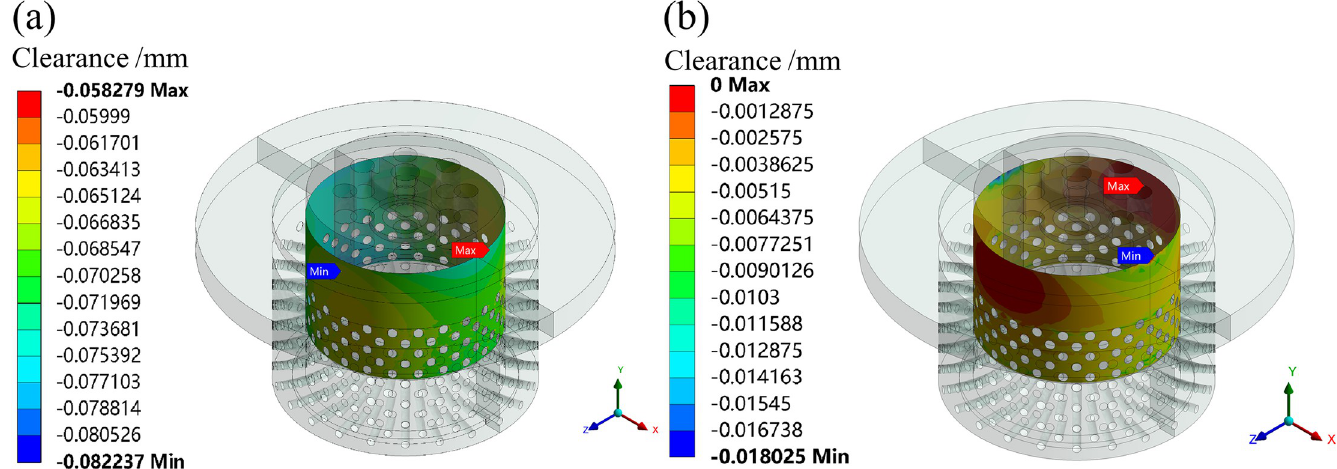
Fig 10. Clearances after deformation of the matching surface at a 50% opening. (a) Initial clearance: 0.073 mm. (b) Initial clearance: 0.010 mm.